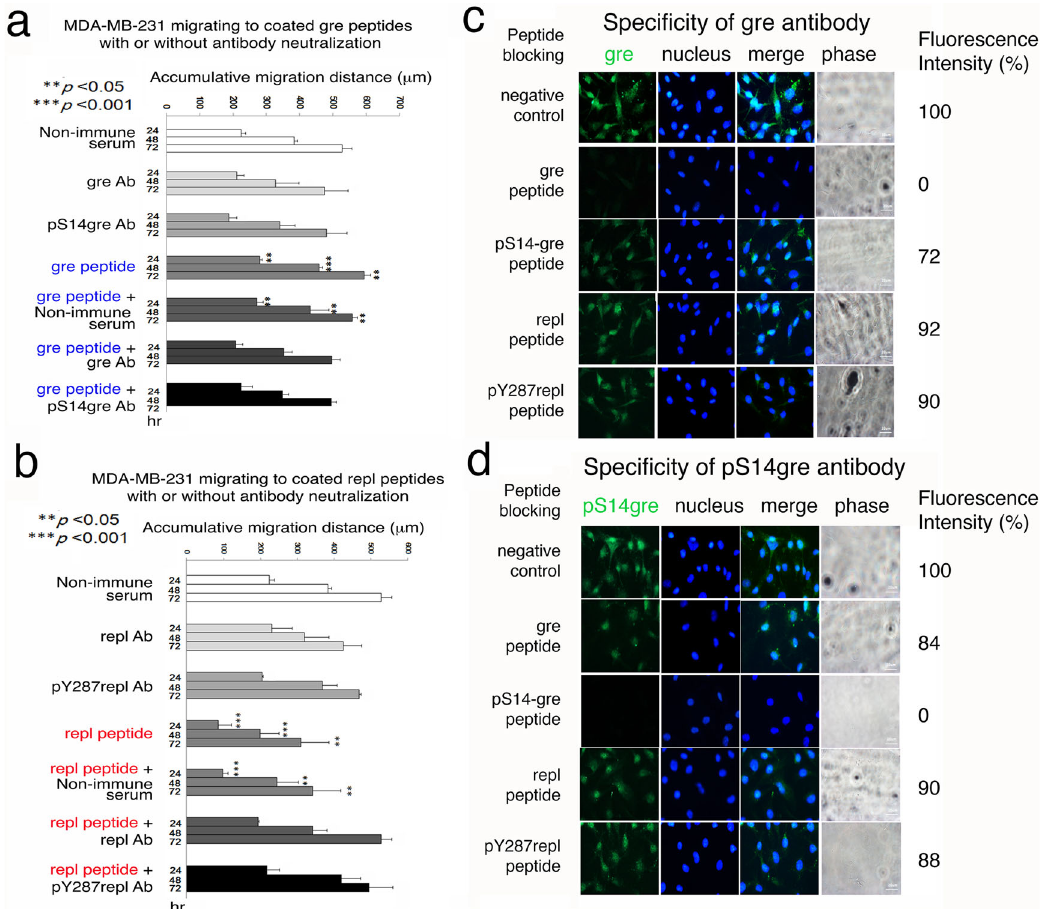
Fig. 6 Neutralization of gre and repl peptides in regulating cell migration by speci fi c antibodies. a , b Gre and pS14gre peptides (200 μ M) were coated onto the plastic surface, followed by washing and then treating with or without aliquots of diluted antisera (1:500), or non-immune sera for controls. Migration of MDA-MB-231 cells to each coated peptide area was imaged at indicated times. Student ’ s t tests were carried out for all experiments versus controls (mean ± standard deviation; n = 3). c , d 3 × 10 5 B16F10 cells were seeded onto cover glasses overnight. Cells were fi xed with 4% paraformaldehyde and permeabilized with 0.25% triton-X PBS. Prior to immunostaining, primary antibodies were pre-adsorbed with or without 1 mM gre, pS14gre, repl, or pY287repl peptides for 1 hr at room